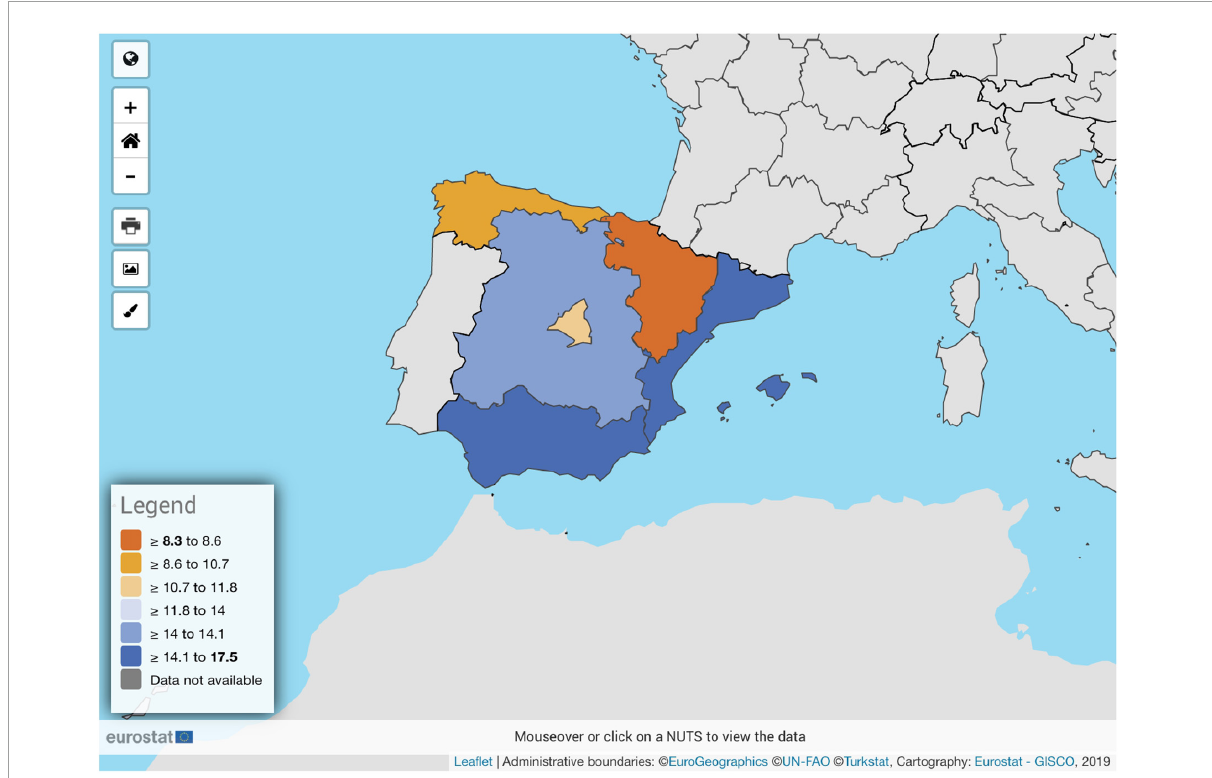
FIGURE1 Early school dropout in Spain by region (Eurostat,